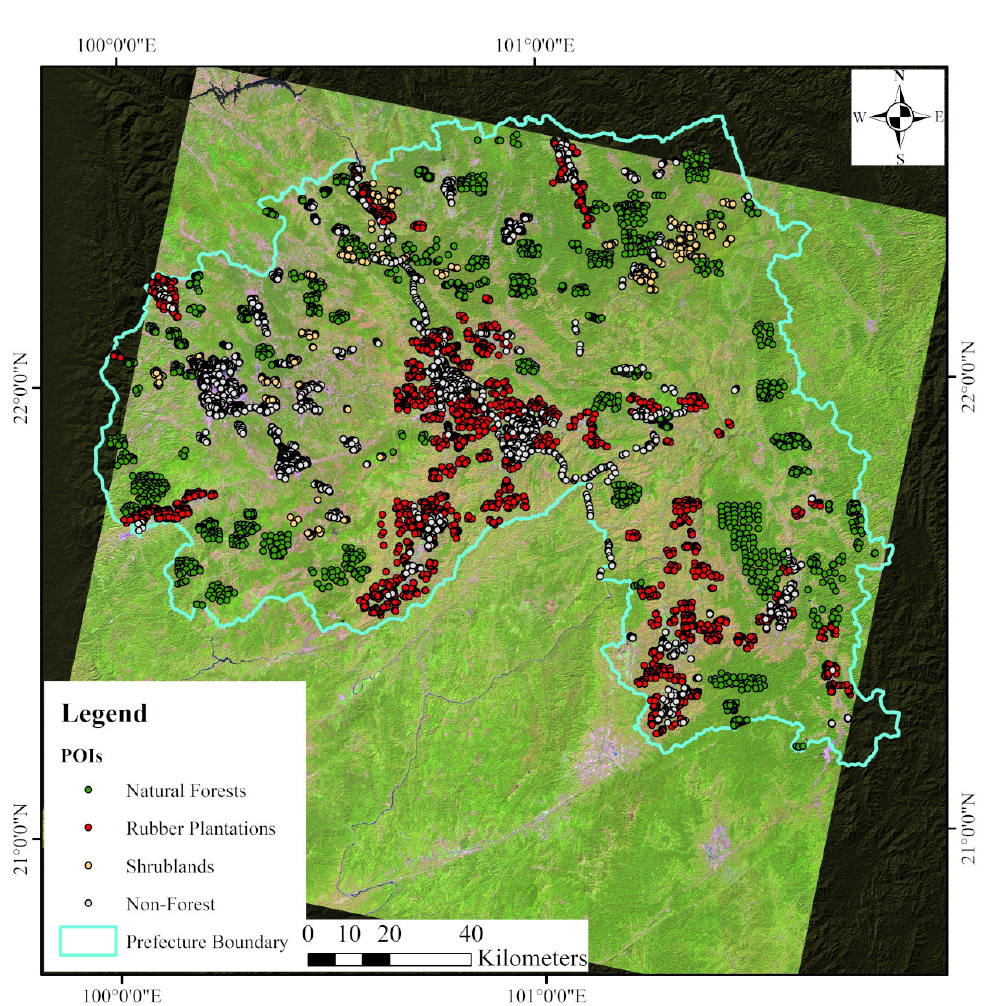
Figure A1. The distribution of ground-truthing data from 2020.